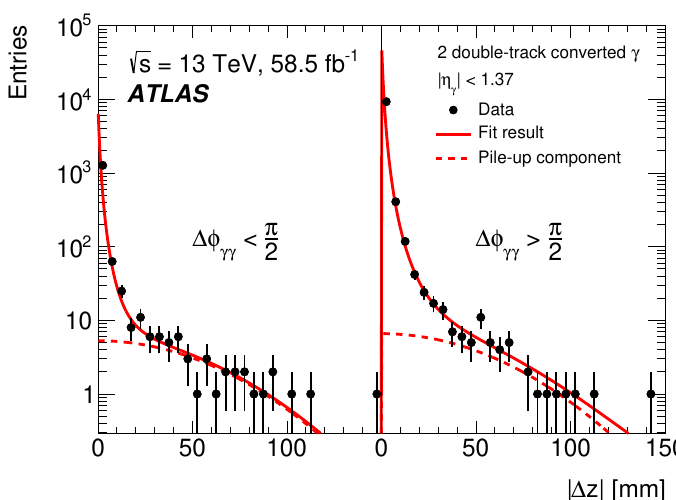
Figure 7. The two-component fit to determine the global normalisation of pile-up events is shown. Data events in which each of the two photon candidates is associated with two inner detector tracks are used for the fit. The dashed lines represent the pile-up-like component of the total model marked with a solid line. The left side of the plot shows the events with azimuthal angular separation of the photon candidates ∆ φ 2 , and the right side of the plot shows the events with ∆ φ γγ < π/ The fit is performed in the two regions